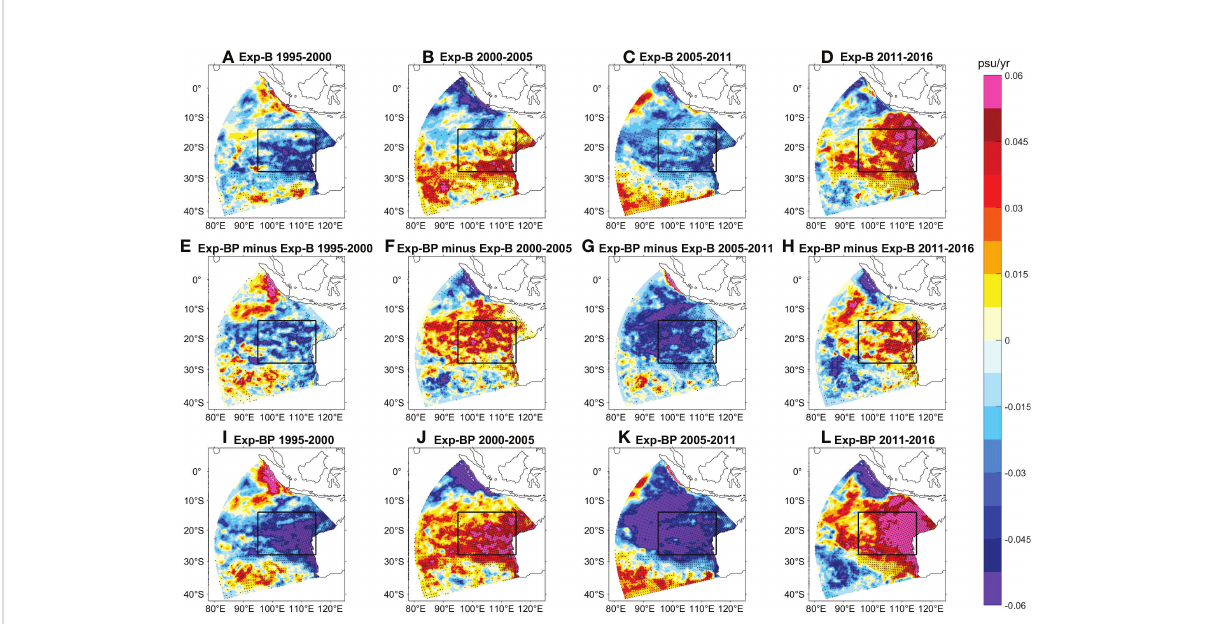
FIGURE 6 Linear trends maps of SSS derived from Exp-B (A – D) , Exp-BP minus Exp-B (E – H) , and Exp-BP (I – L) for the periods of 1995-2000, 2000-2005, 2005-2011, and 2011-2016. Stippling indicates signi fi cant trends at 90% con fi dence level based on a Mann-Kendall test. Black lines denote the SEIO region.